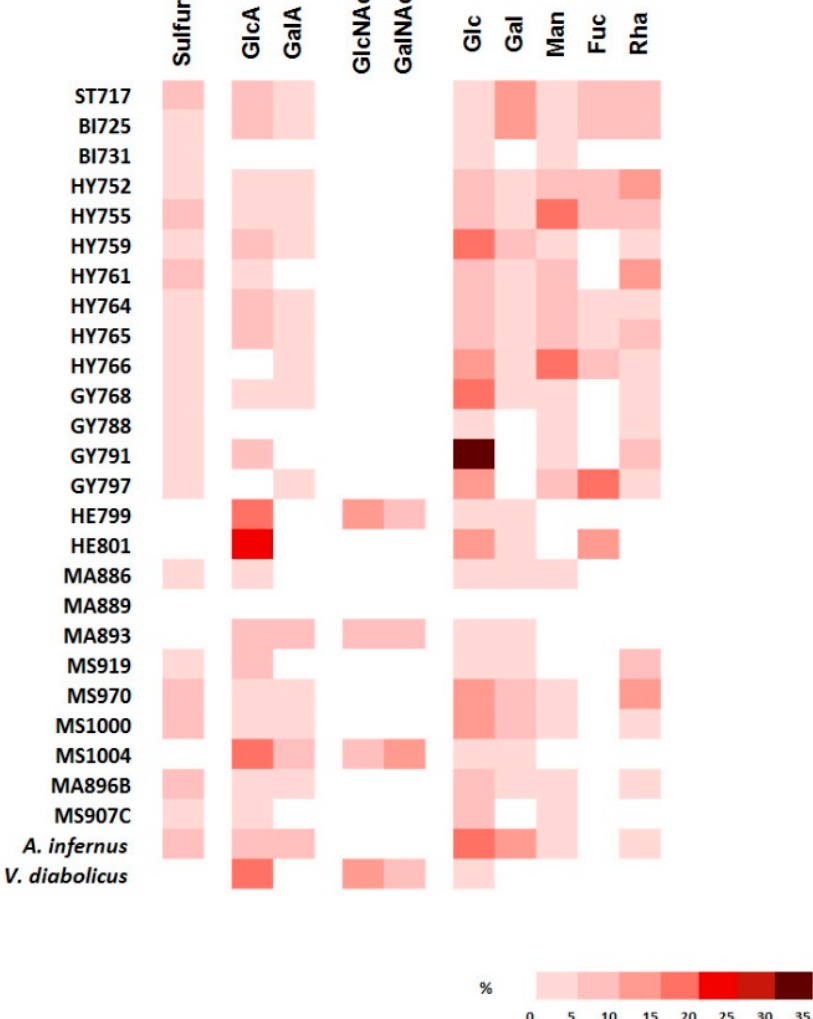
Figure 2. Sulfur content and monomeric composition (% w / w ) of EPS for each strain. The EPS were extracted from a 100 mL culture broth.